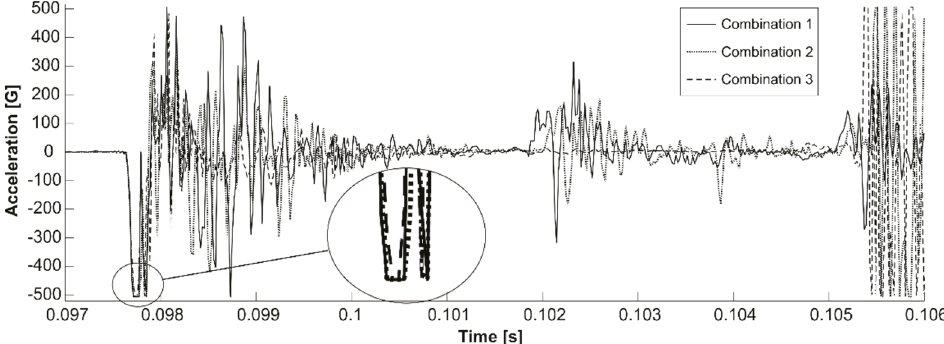
Figure 10. The measured time profile of the actuator acceleration acquired by performing dynamic measurement.